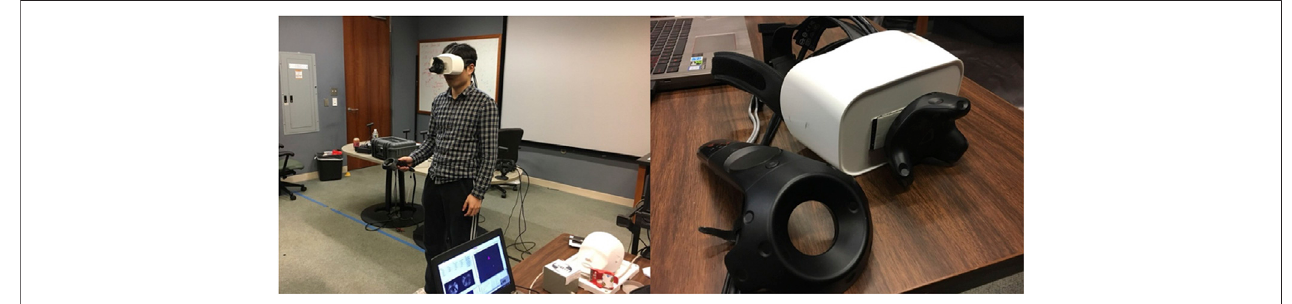
FIGURE 4 | One of the authors showing the experimental setup and the FOVE headset (with an HTC Vive tracker) and an HTC Vive Controller.